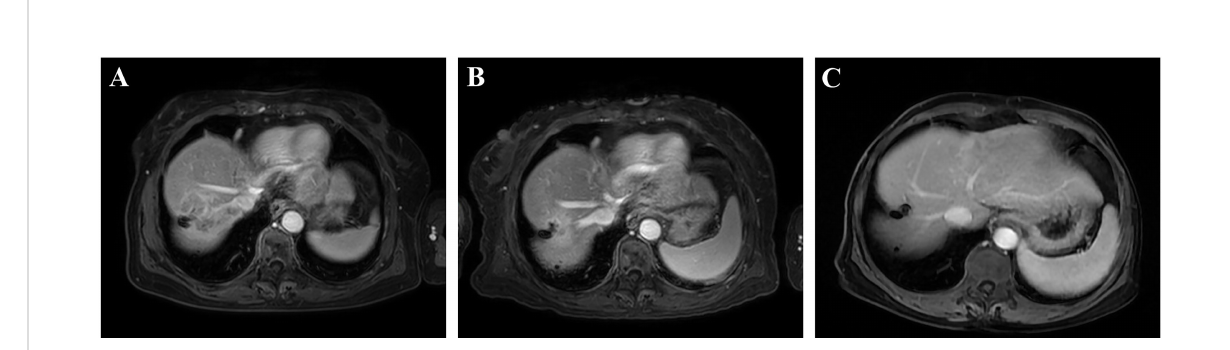
(Figure S2, P > 0.05). Thirty-one patients reached PFS event until Mar 2022 and eight of them suffered without any other treatment.